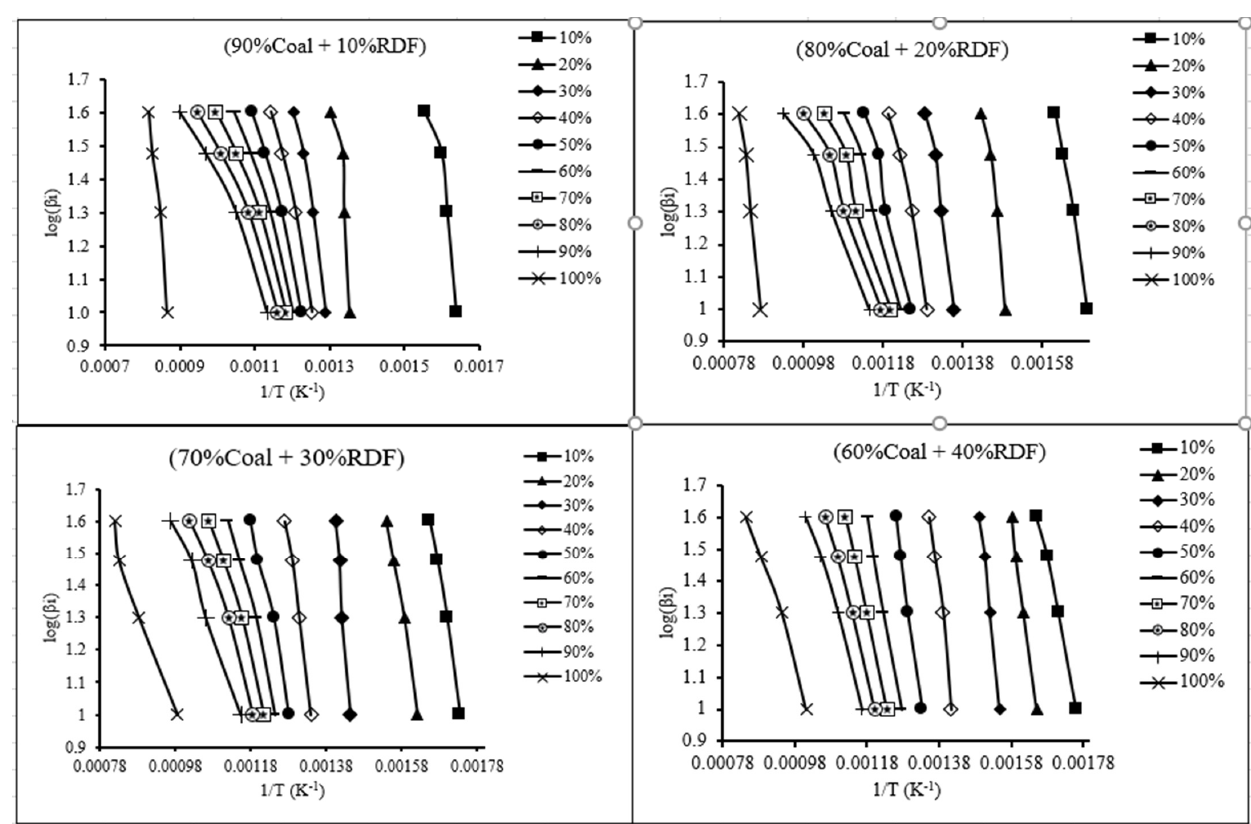
Figure 3 . Plots for kinetic model, FWO for various blends of coal/RDF . Figure 3. Plots for kinetic model, FWO for various blends of